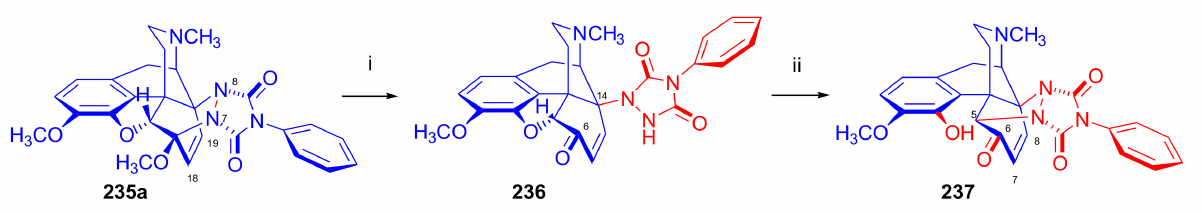
Figure 64. Rearrangement of thebaine-PTAD adduct. Reagents and conditions : (i): cc. hydrochloric acid, acetone, 50 ◦ C; (ii): crystallization from hot ethanol or